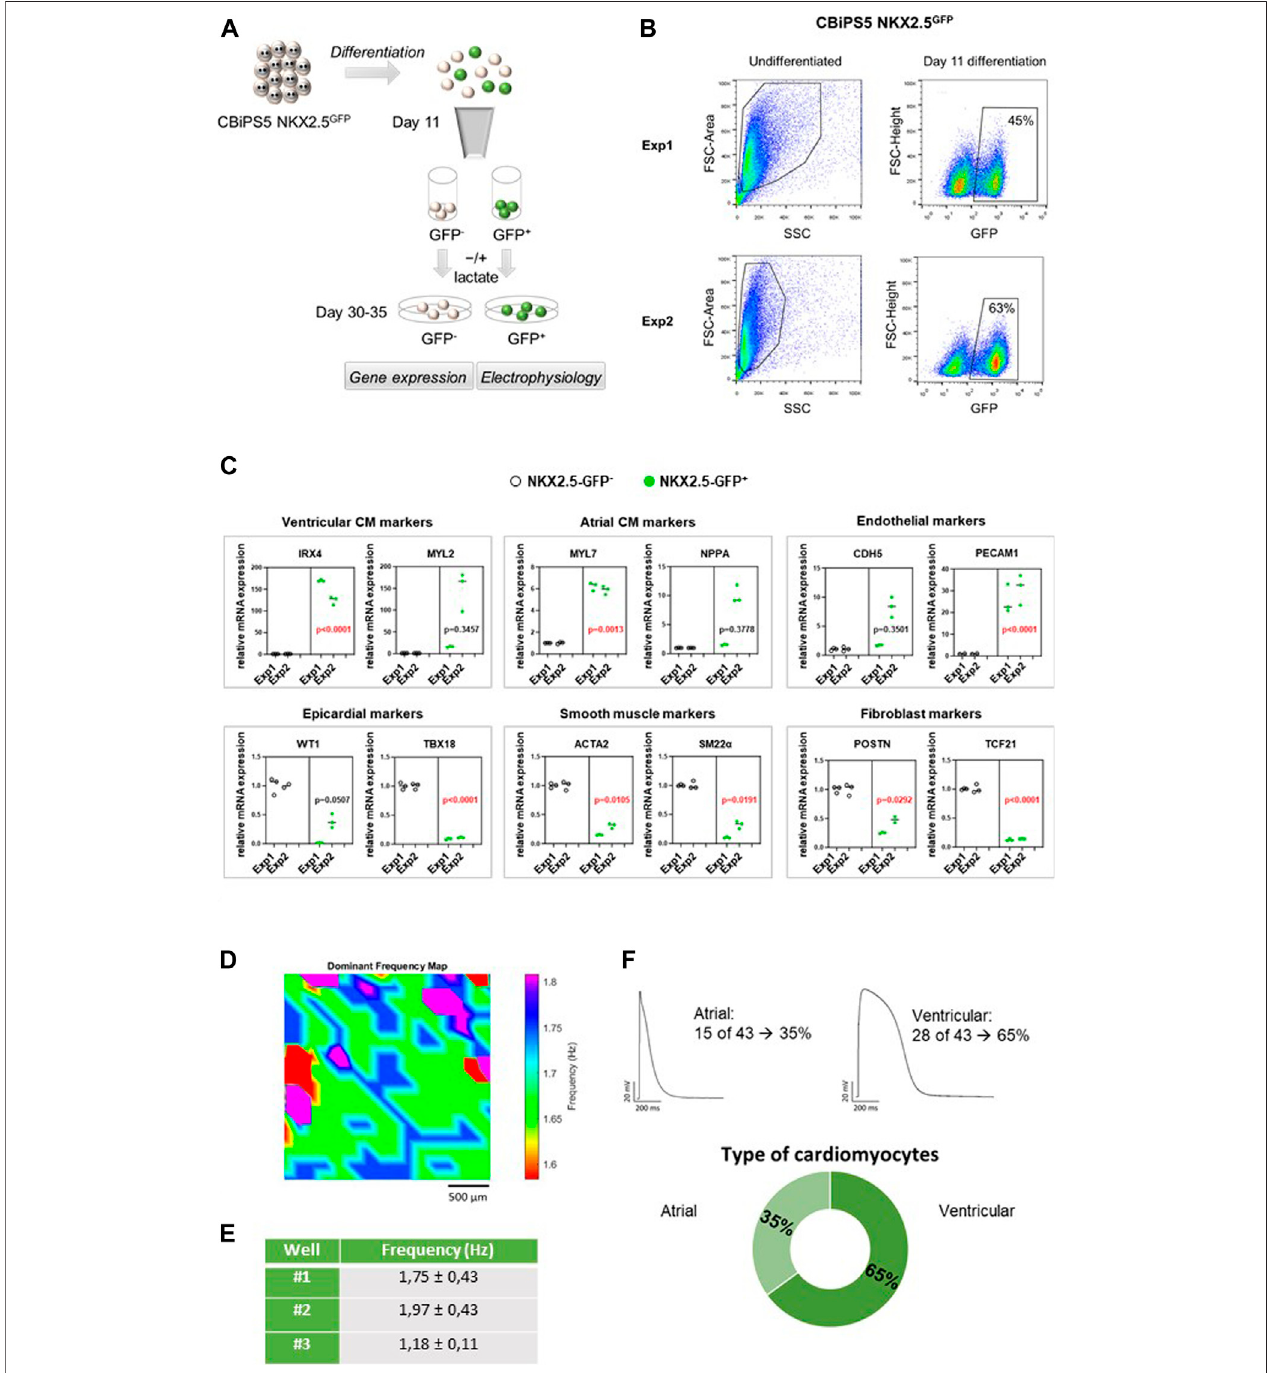
FIGURE 2 | NKX2.5-GFP + cell characterization. (A) Representation of the analyses performed in GFP + and GFP − cells sorted at day 11 of differentiation. (B) Dot plotdiagramofGFP + cellsobtainedby fl owcytometryanalysisofpre-sortedCBiPS5NKX2.5 GFP cellsatday11ofcardiacdifferentiationintwodifferentassays. (C) Gene expression analysis of speci fi c cardiac lineage markers in NKX2.5-GFP + (green circles) and NKX2.5-GFP - (black circles) cell derivatives at day 30 of cardiac differentiation. Two biological replicates (Exp1 and Exp2), three technical replicates in each. Median of three technical replicates in two biological replicates (Exp1 and Exp2) are represented; the p value is annotated in each graph, GFP − group vs GFP + group using Nested-t tests. (D) Activation frequency map for well #1 is shown. Baseline recordings acquired from 10 to 30 frames per second in a fi eld of view of 2.5 mm (E) Activation frequency registrations (Hz) obtained by optical mapping of NKX2.5-GFP + cells-derived CM in three independent wells. (F) Patch-clamp recordings in GFP + cells-derived CM. Atrial and ventricular-like action potentials and percentages of each cardiomyocyte subtype are represented.